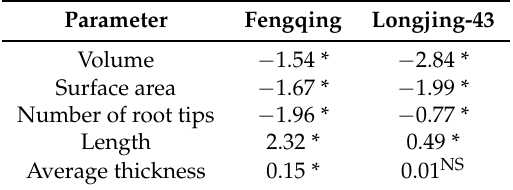
Table 2. Fold change of response to P treatments (log 2[ − P/+P] ) in mean volume, surface area, length, average thickness, and tips of